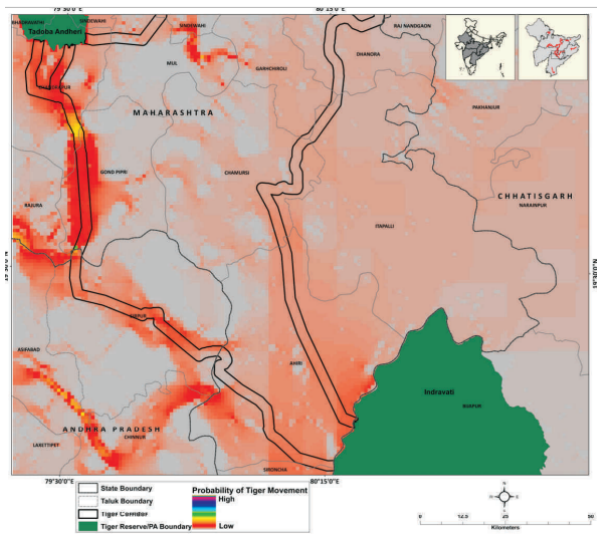
Figure 14: Potential Habitat